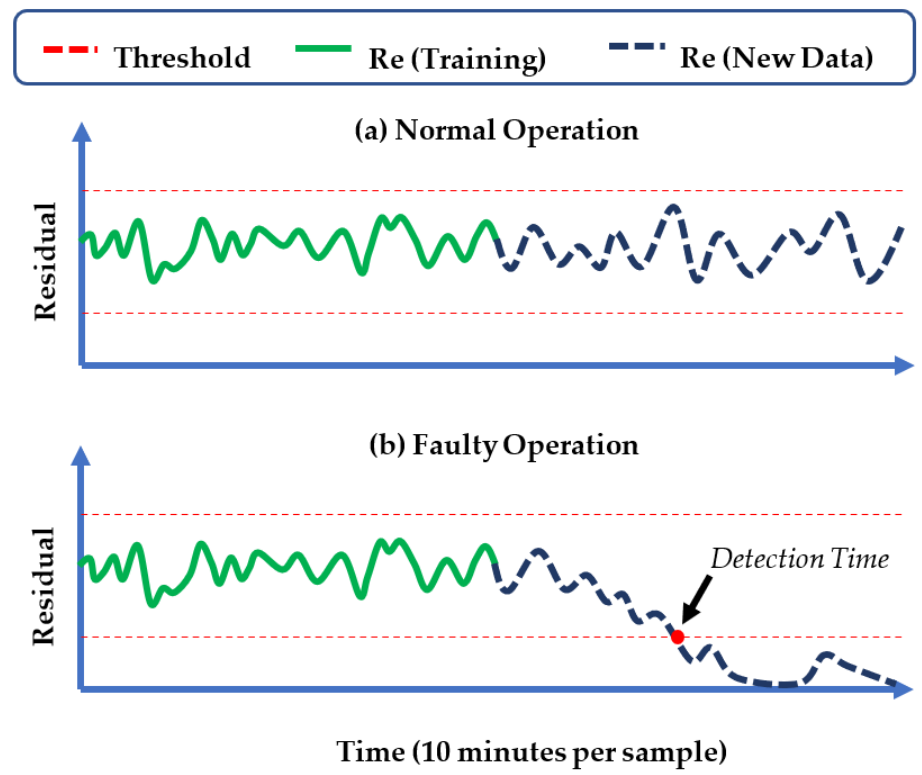
Figure 4. A typical control chart for power curve-based condition monitoring. Condition monitoring can be performed in two ways [54] namely, online and offline.